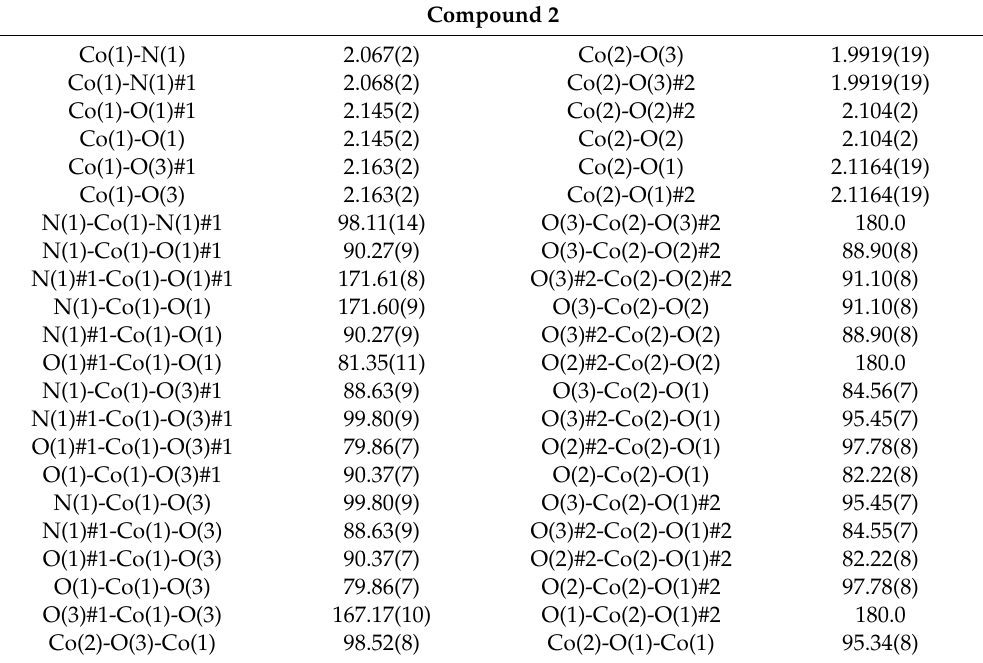
Table 3. Selected bond distances (Å) and angles ( ◦ ) for compound 2